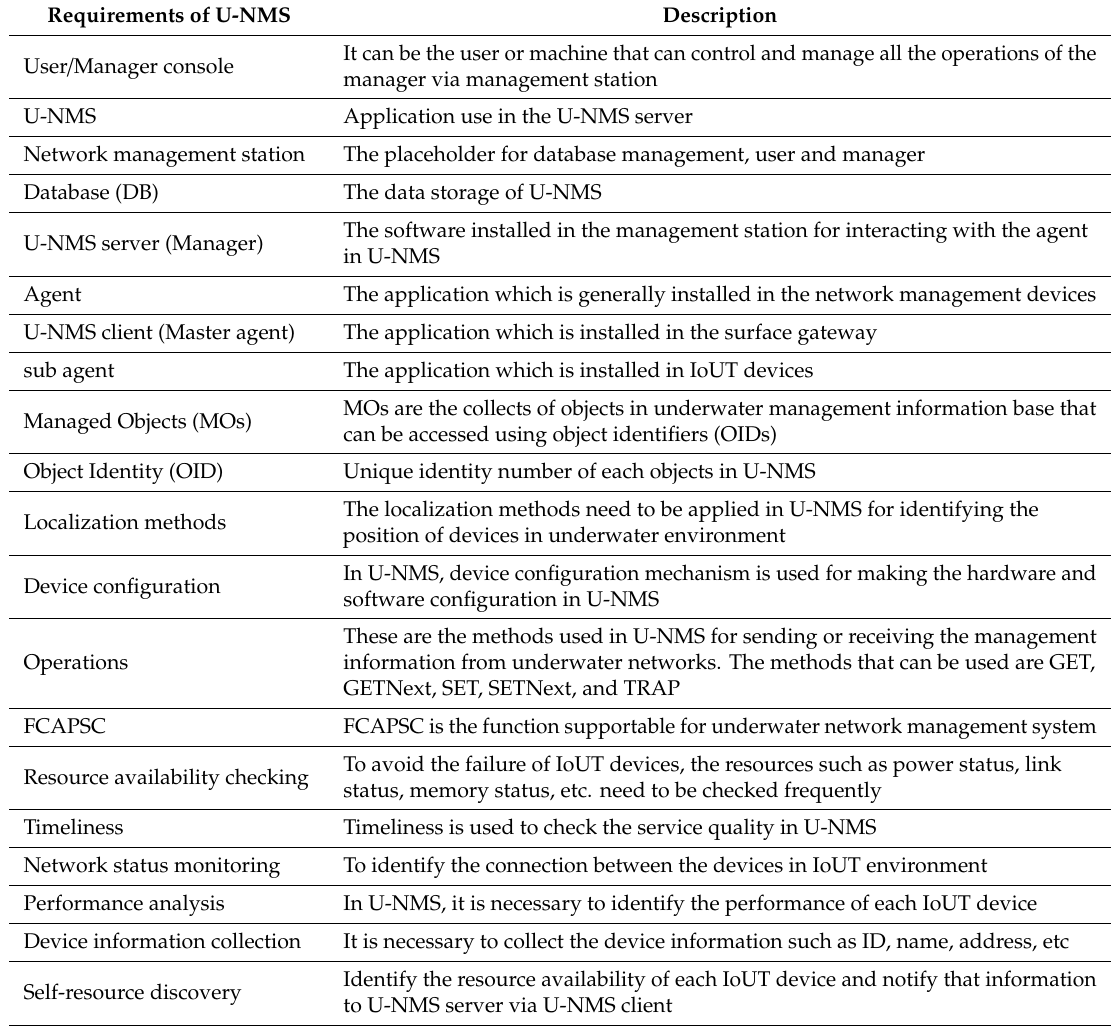
Table 6. Requirements of proposed